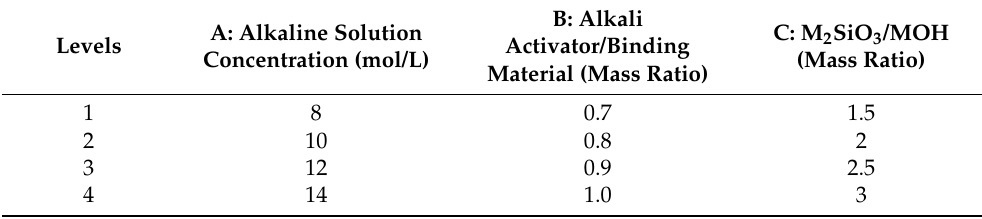
Table 2. The design of the orthogonal